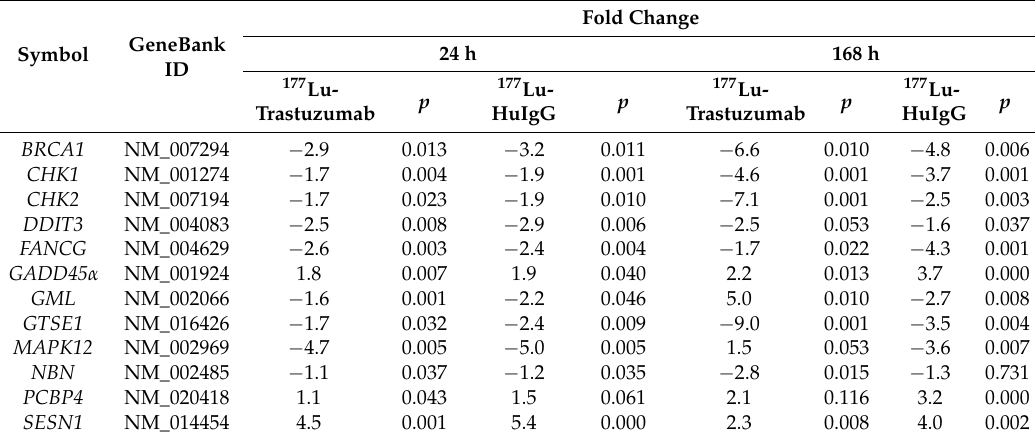
Table 3. Expression of genes involved in cell cycle in LS-174T i.p. xenografts following treatment with 177